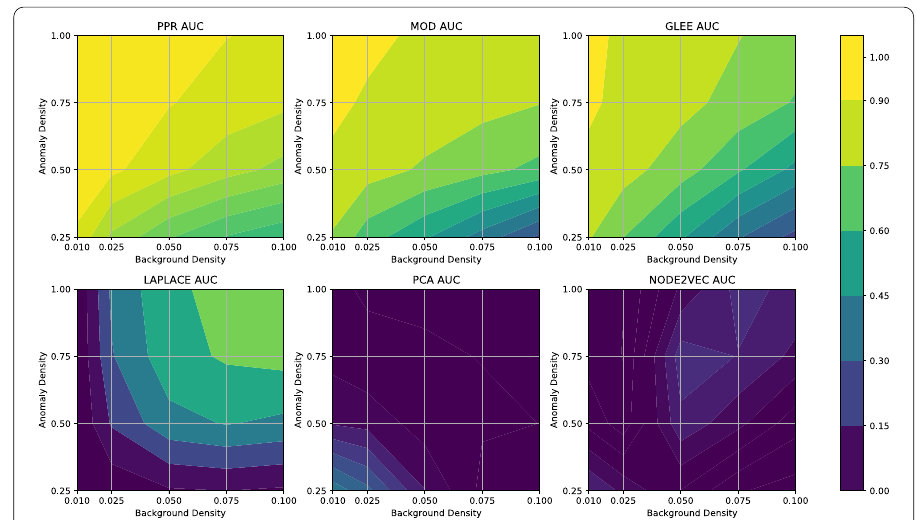
Fig. 10 AUC versus background and anomaly density for all tested embeddings. In general, we observe that PPR performs best in all scenarios presented in “Data generation for embedding analysis”